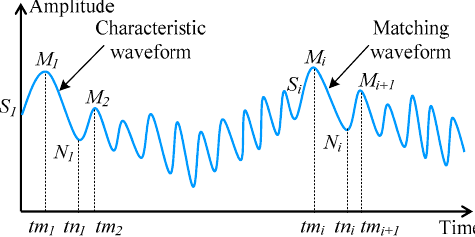
Figure 2. Sketch map of the waveform matching extension.